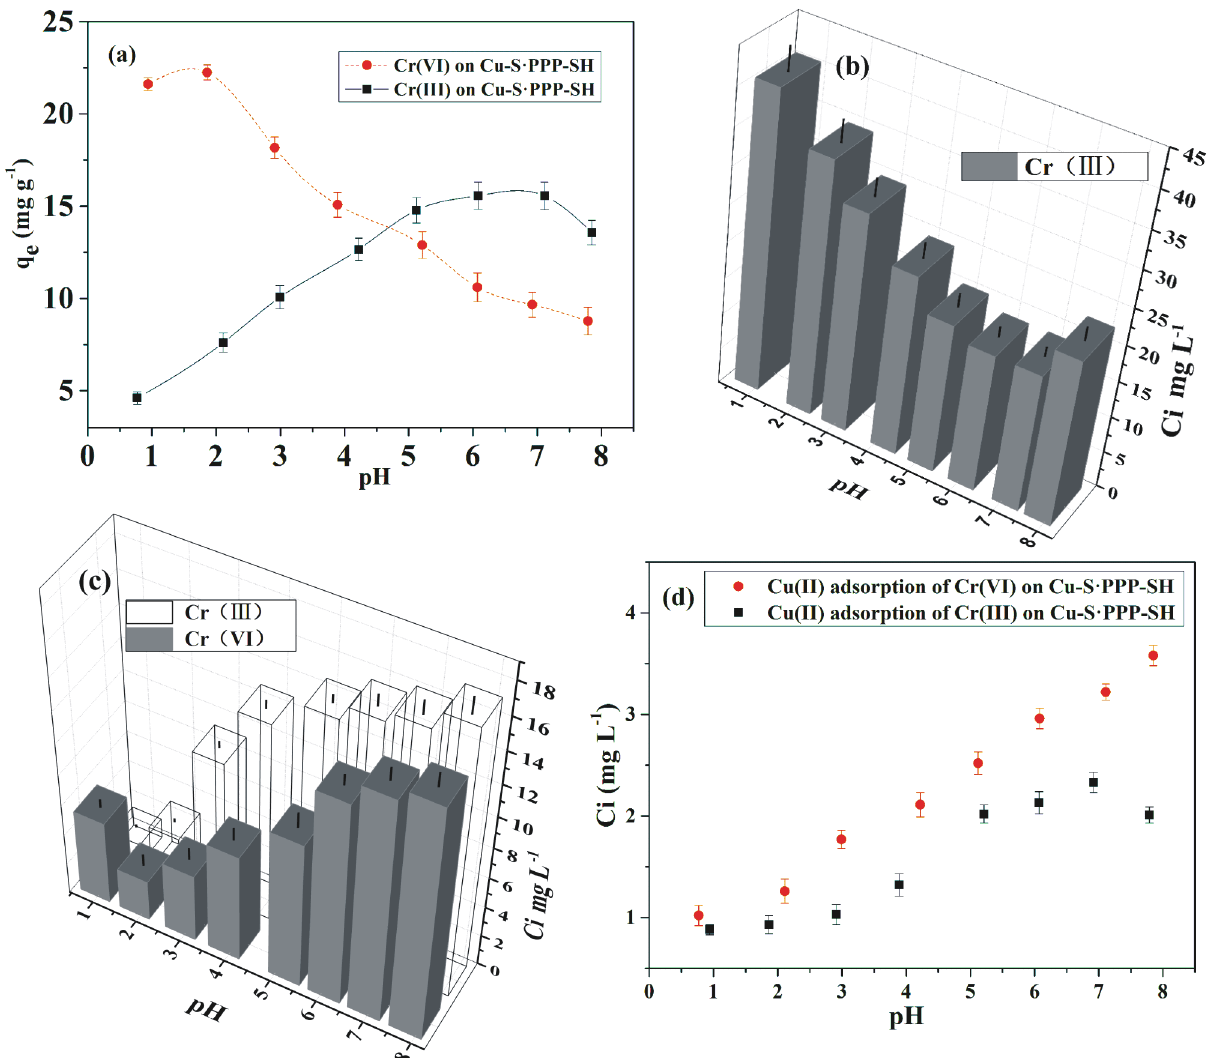
Figure 2: (a) Effect of equilibrium pH on adsorption of Cr(III) and Cr(VI) by Cu-S·PPP-SH; (b) Variation of concentrations of chromium ions with pH after adsorption in the Cr(III)-absorbed system; (c) Variation of concentrations of chromium ions with pH after adsorption in the Cr(VI)- absorbed system; (d) Variation of concentrations of Cu(II) with pH after adsorption in both systems. Conditions: initial metal ion concentrations 50 mg L -1 , adsorbent concentrations 2.0 g L -1 , temperature 25